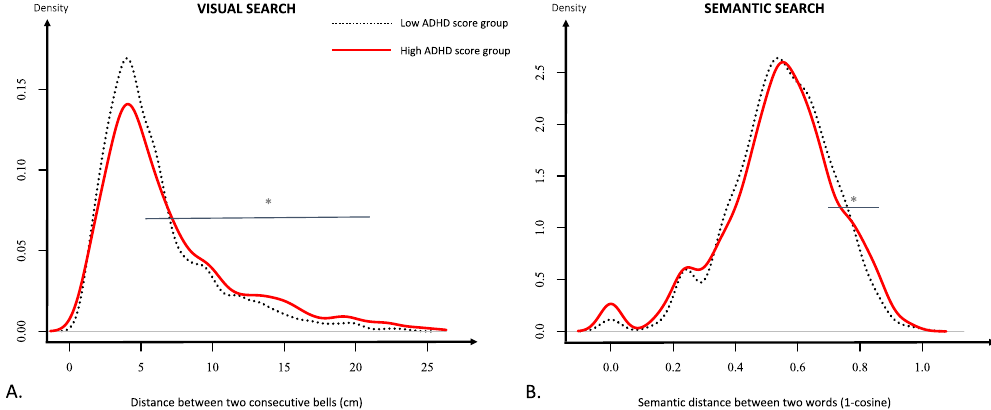
Figure 2. Distribution of distances between two consecutive targets in the visual search task ( A ) and in the semantic search task ( B ), for children scoring high (pain lines) and low (dotted lines) on the ADHD rating scale (ADHD-rs), according to a median split (m = 9) on the scores. The horizontal bars correspond to the range of a significant difference in the density distributions, assessed by means of bootstrap with a cluster-wise significance level of 0.05–from 0.56 to 0.99, for the visual search task and from 0.87 to 0.99 for the semantic search task. On the semantic search task, the distribution of similarities shows two minor peaks: the first one at 0 corresponds to the immediate repetitions (ex: dog-dog). The second one correspond to the “dog-cat” pairs with semantic similarity of